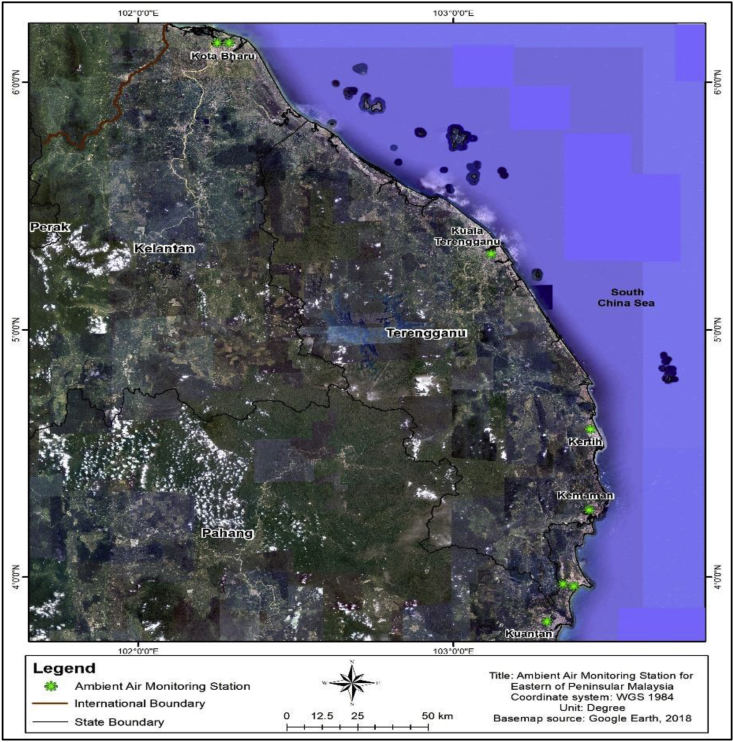
The Continuous Air Quality Monitoring (CAQM) station.